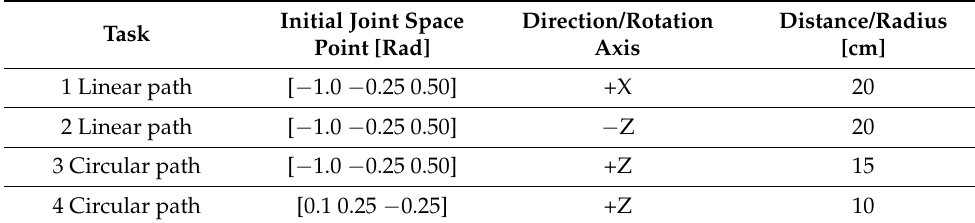
Table 2. Definition of executed tasks.